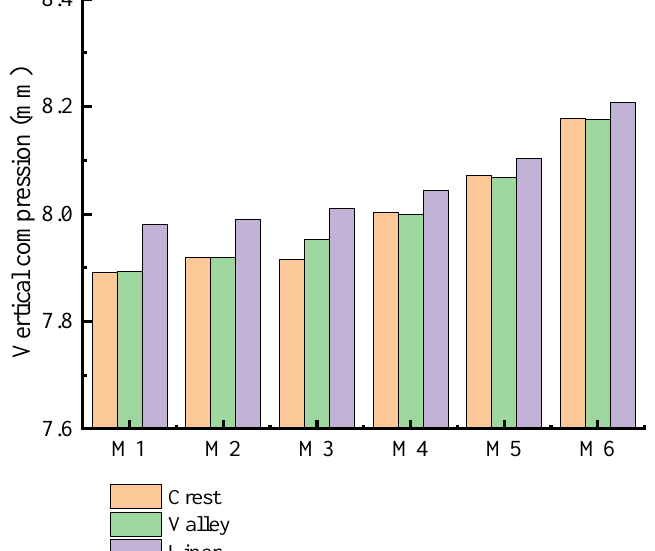
Figure 15. Radial displacement of interior wall.